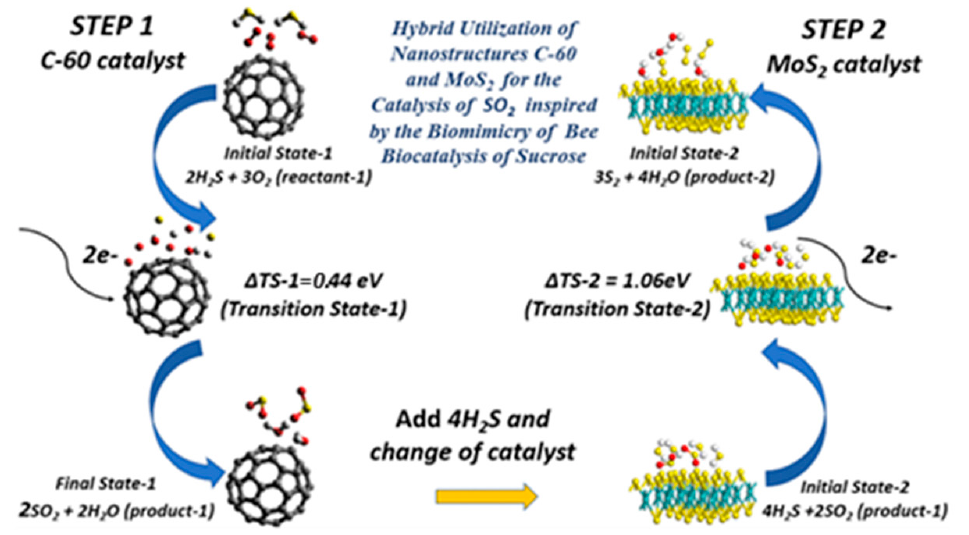
Figure 8. Bee biomimicry inspired rendering of both steps of the initial, transition, and final states for geometrically optimized doubly ‐ charged fullerene C ‐ 60 and AA stacked MoS 2 heterogeneously catalyzing the oxidation–reduction of sulfur dioxide to elemental sulfur. The Mo, S, O, and H atoms are represented by cyan, yellow, red, and white spheres, respectively. The curved arrows demonstrate the introduction of two electrons into the reactant states, causing bond breakage in the predicted relative transition states of step 1 and step 2.